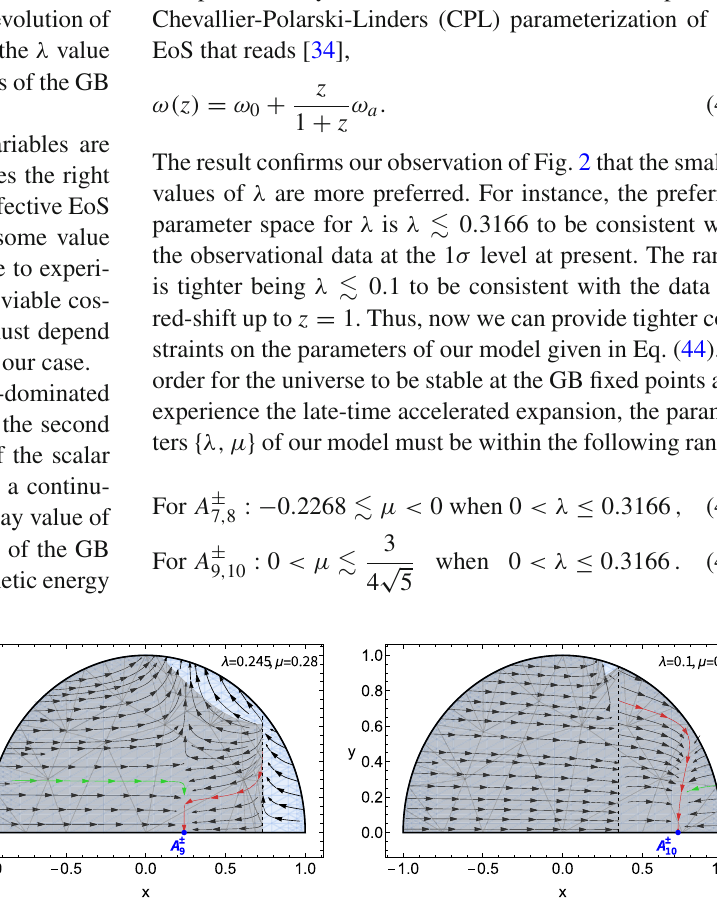
tories toward the fixed points A ± , A ± , and A ± when their stability 7 , 8 9 10 conditions are satisfied. The dashed lines at x = x div indicate the diver- gence of dynamical equations, see Eq.